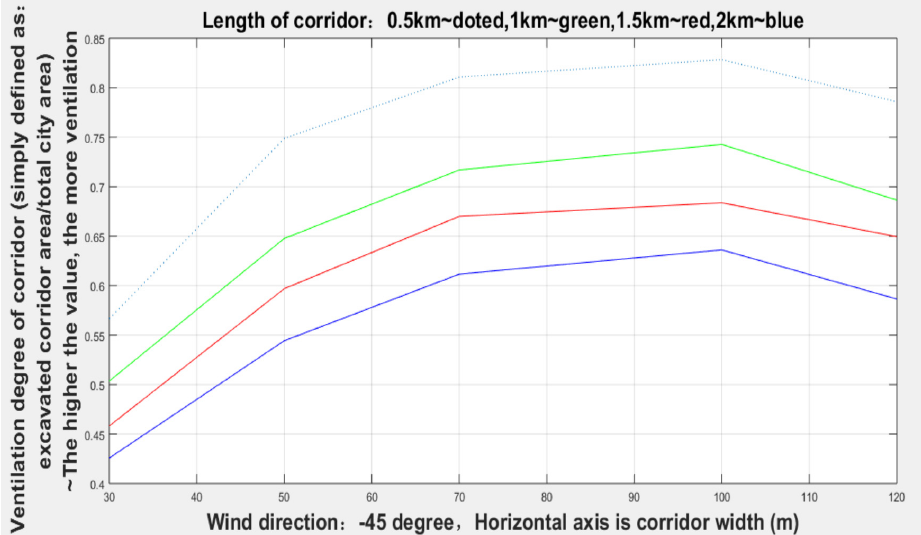
Figure 15. Ventilation conditions of corridors with different widths in the direction of − 45 degrees. Table 2. The degree of ventilation of the length and width of each corridor when the wind direction was − 45 degrees.